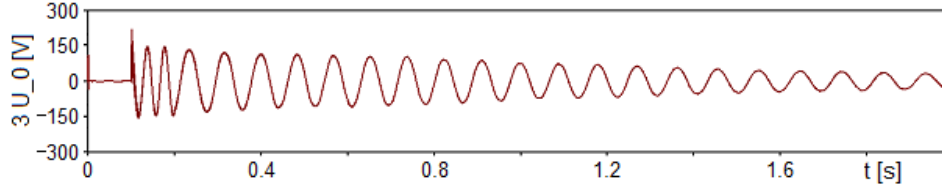
Figure 7. The voltage waveform in the open delta circuit resulting from changing the magnetization characteristics of the voltage transformers from waves 2 to 3.